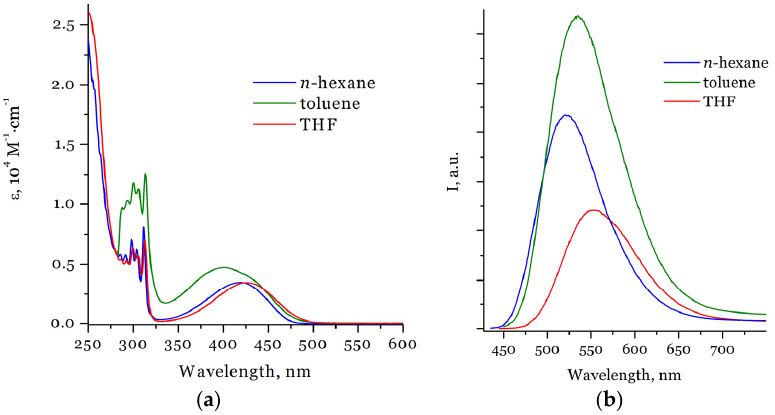
Figure 7. ( a ) UV-Vis spectra of 1 in n -hexane, toluene and THF solutions (concentration 10 − 5 M). ( b ) The corresponding emission spectra.